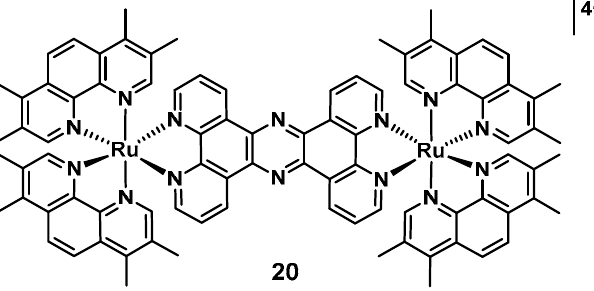
Figure 8. The dinuclear, tetracationic ruthenium polypyridyl complex reported by Smitten et al. [94].